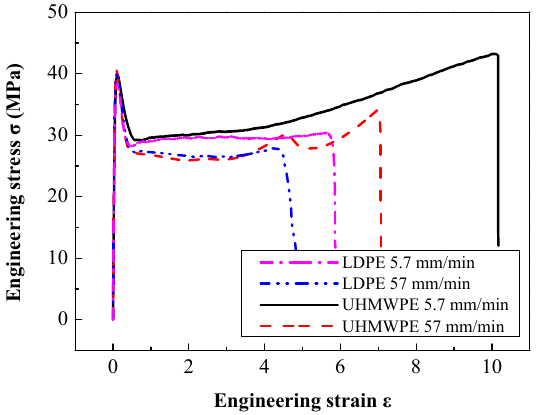
Figure 7. Tensile engineering stress-strain curves of LDPE and UHMWPE at 0° angle and strain rates of 0.001 s − 1 (5.7 mm/min) and 0.01 s − 1 (57 mm/min).